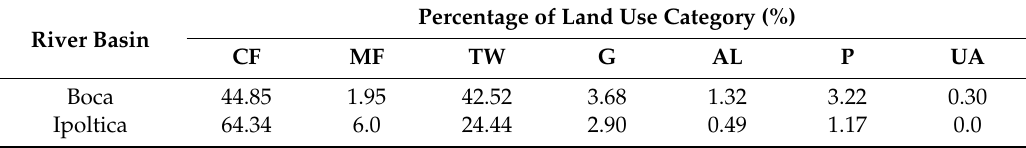
The percentage of land use categories in 2018 for the Boca and Ipoltica River basins (CF–coniferous forest, MF–mixed forest, TW–transitional woodland-shrub, G–grasslands, AL–agriculture land, P–pastures, UA–urbanized area).